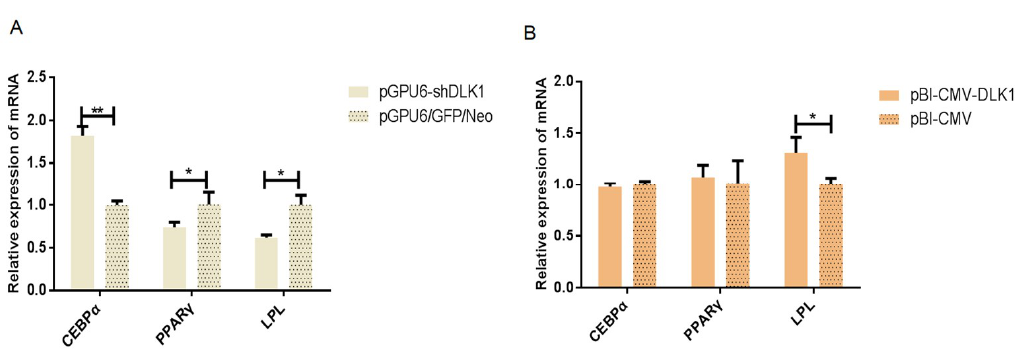
Figure 5. The mRNA expression of DLK1 and lipid metabolism-related genes in BFFs after interference ( A ) or overexpression of ( B ) the DLK1 gene. * means p value < 0.05, ** means p value < 0.01. 3.4. Determination of the Fatty Acid Content in BFFs after Interference and Overexpression of the DLK1